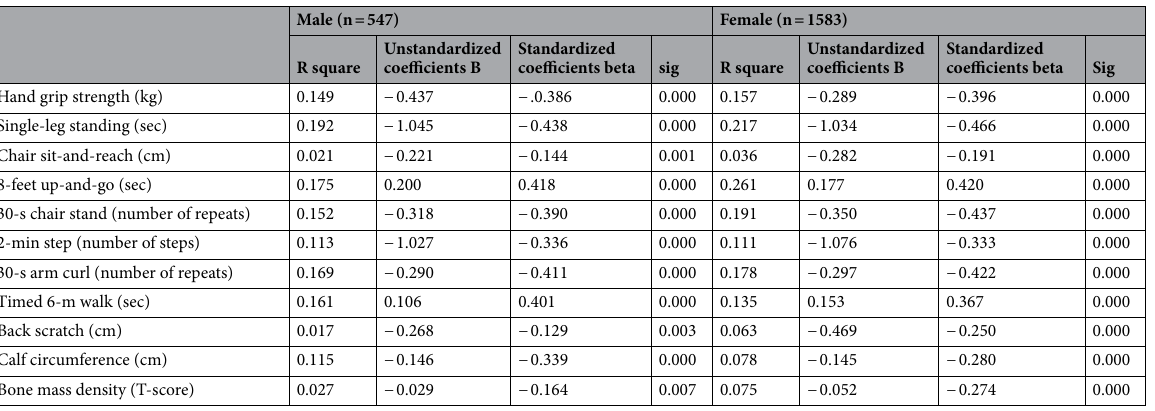
Table 5. Results of the simple linear regression analysis performed using age as the predictor variable and physical fitness parameters as the dependent